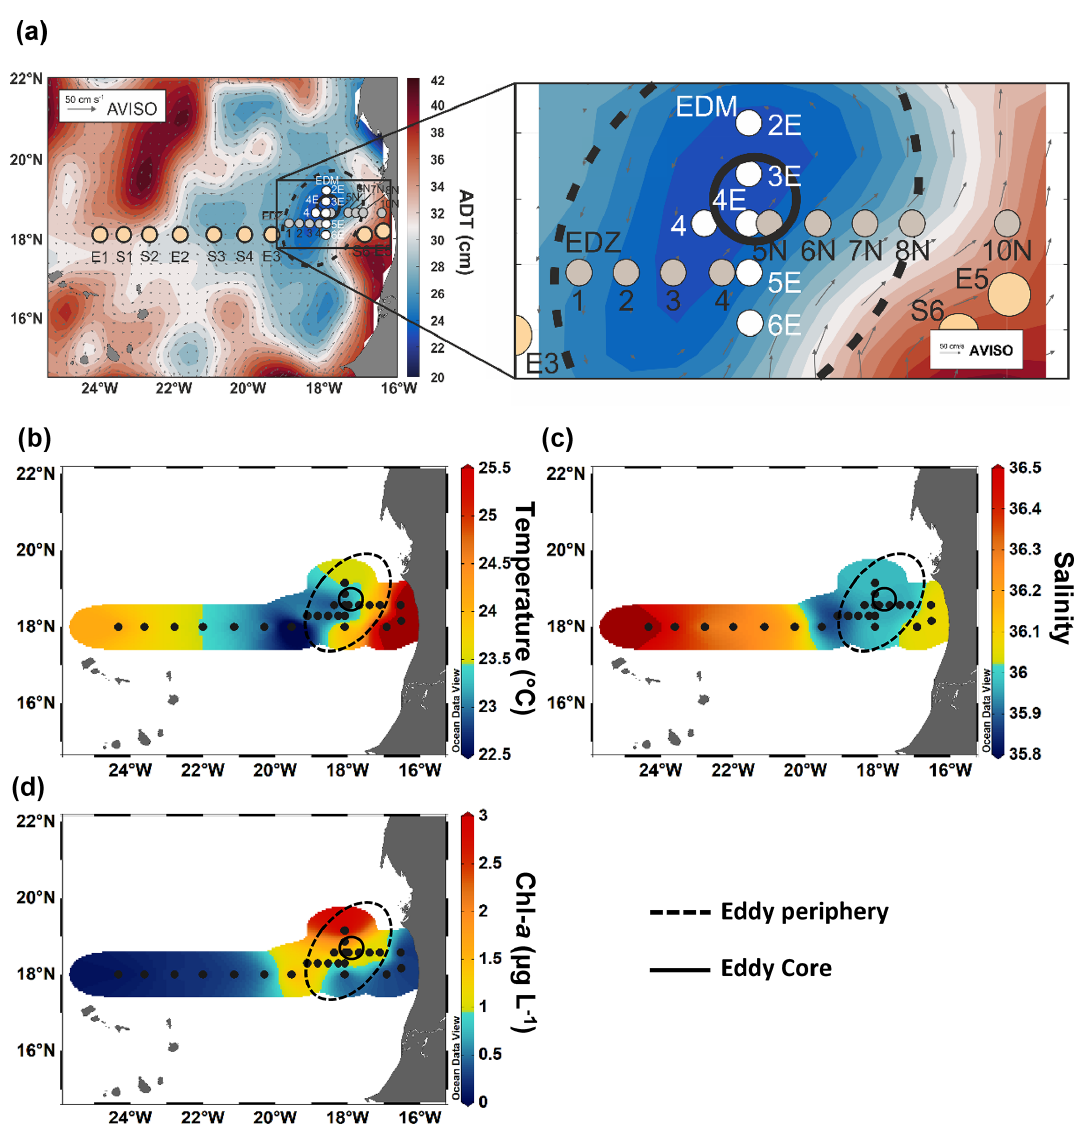
Figure 1. Sampling stations during RV Meteor cruise M156 including zoom-in into the eddy (a) , temperature at 5m depth (b) , salinity at 5m depth (c) , and chlorophyll a at 5m depth (d) . The background in (a) shows the variations in absolute dynamic topography (ADT) obtained from https://www.aviso.altimetry.fr, last access: 4 December 2021. The direction and speed of surface water geostrophic currents are shown as arrows. The solid circle in (a) – (d) indicates the core of the eddy, and the dashed circle outlines the